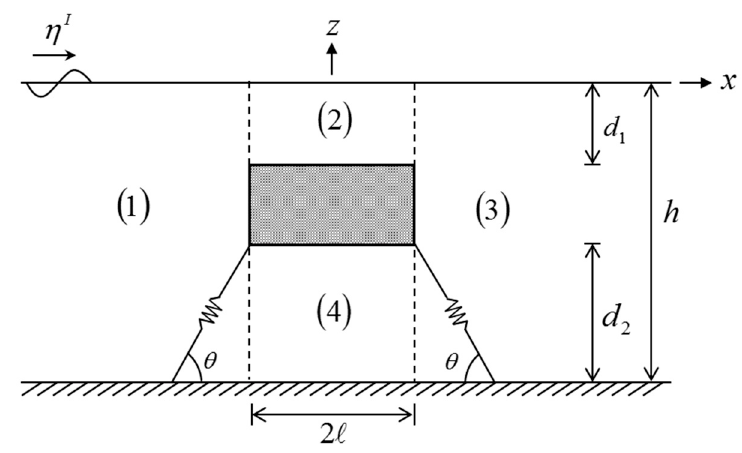
Figure 1. Definition sketch of waves incidents on an underwater floating structure with moorings.